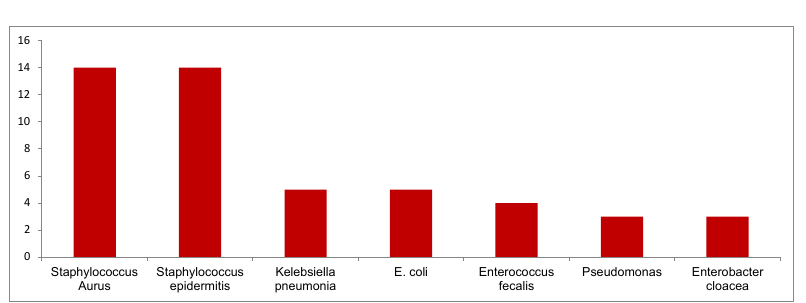
Figure 2. Common microorganisms responsible for infection of red